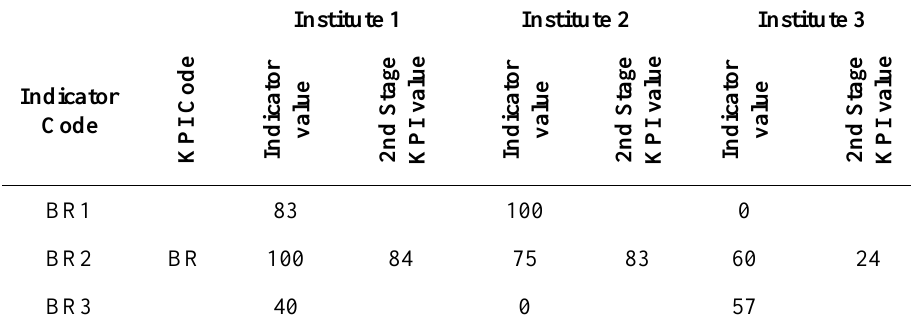
Table 5: Indicator Values and Second Stage KPI Values for the Three